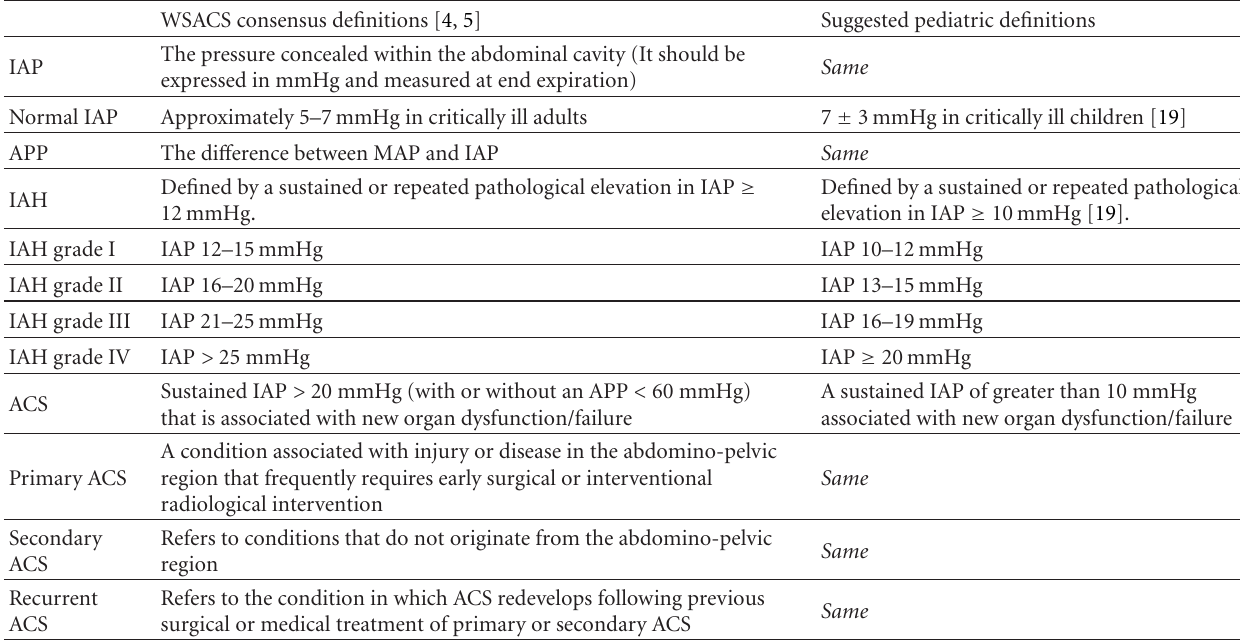
Table 2: The WSACS consensus definitions and suggested pediatric